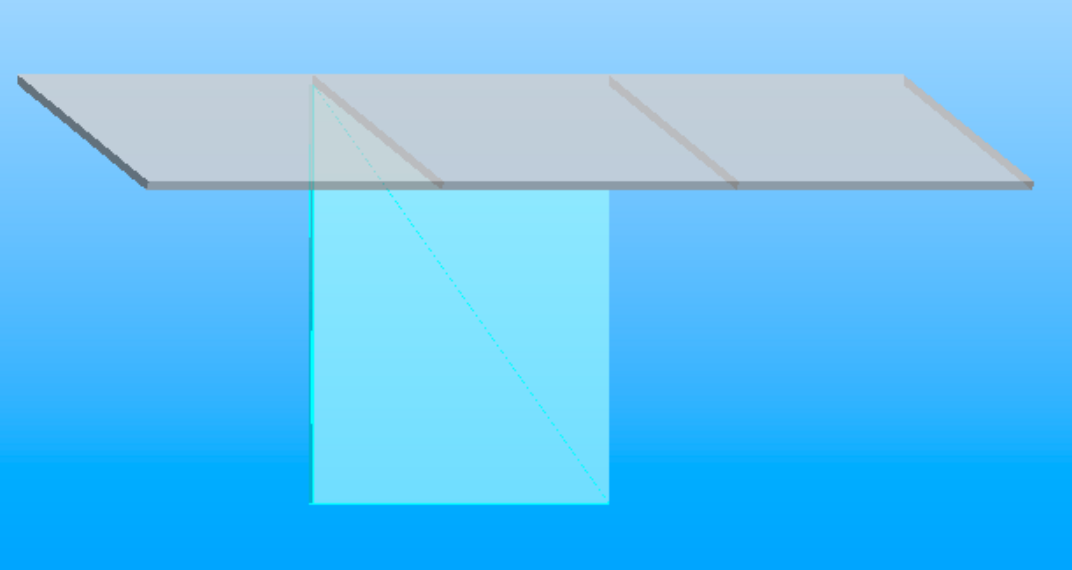
Figure 15. Shading plate with a longer length.